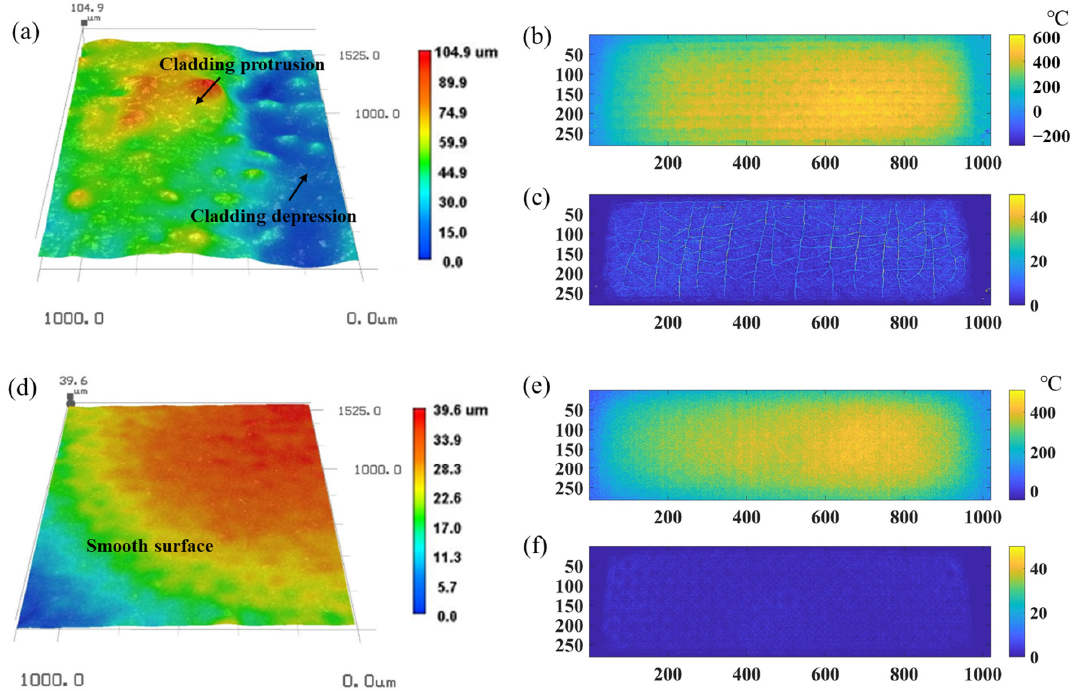
Figure 19. Thermographic detection of different surface structures: ( a ) local 3D morphology of repair area 1; ( b ) combined form of temperature change field in repair area 1; ( c ) Prewitt edge detection results for temperature change field in the repair area 1; ( d ) local 3D morphology of smooth area; ( e ) combined form of temperature change field with smooth area after mask treatment; ( f ) Prewitt edge detection for temperature change field in smooth areas.